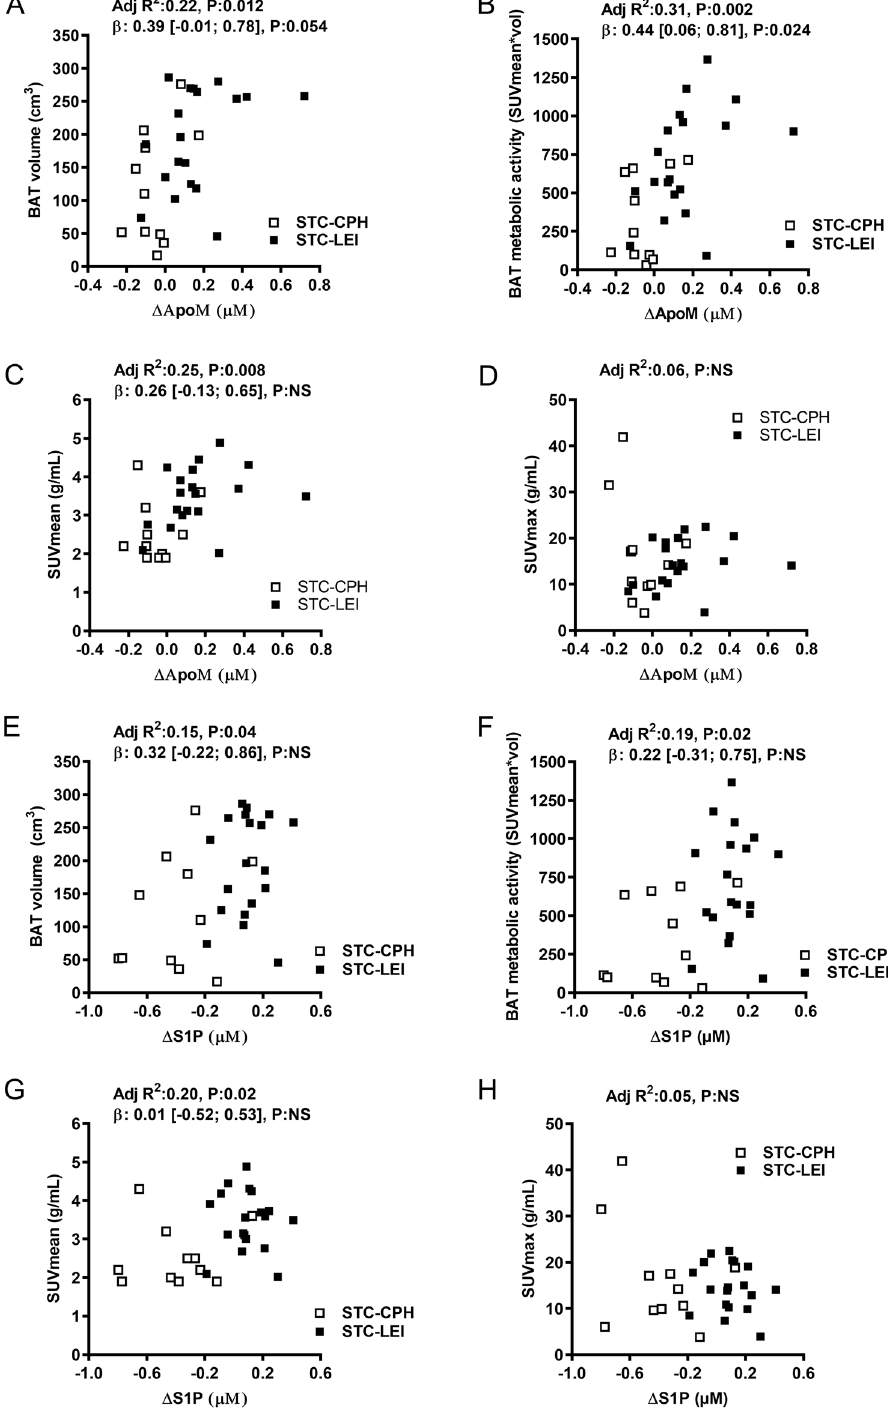
Figure 5. Association between brown adipose tissue (BAT) parameters and delta plasma apoM and S1P levels (ΔapoM and ΔS1P). Delta plasma apoM and S1P levels (cold-induced changes in plasma concentration) were associated with BAT volume (A and E), metabolic activity (B and F), SUVmean (C and G) and SUVmax (D and H). Data were tested for homogeneity before combining the studies in linear regression analysis adjusting for a study place. Adj R 2 ; adjusted R-square value. β; beta-coefficient. []; 95%-confident interval. STC-CPH (n = 11); short-term cold, Copenhagen. STC-LEI (n = 19); short-term cold,